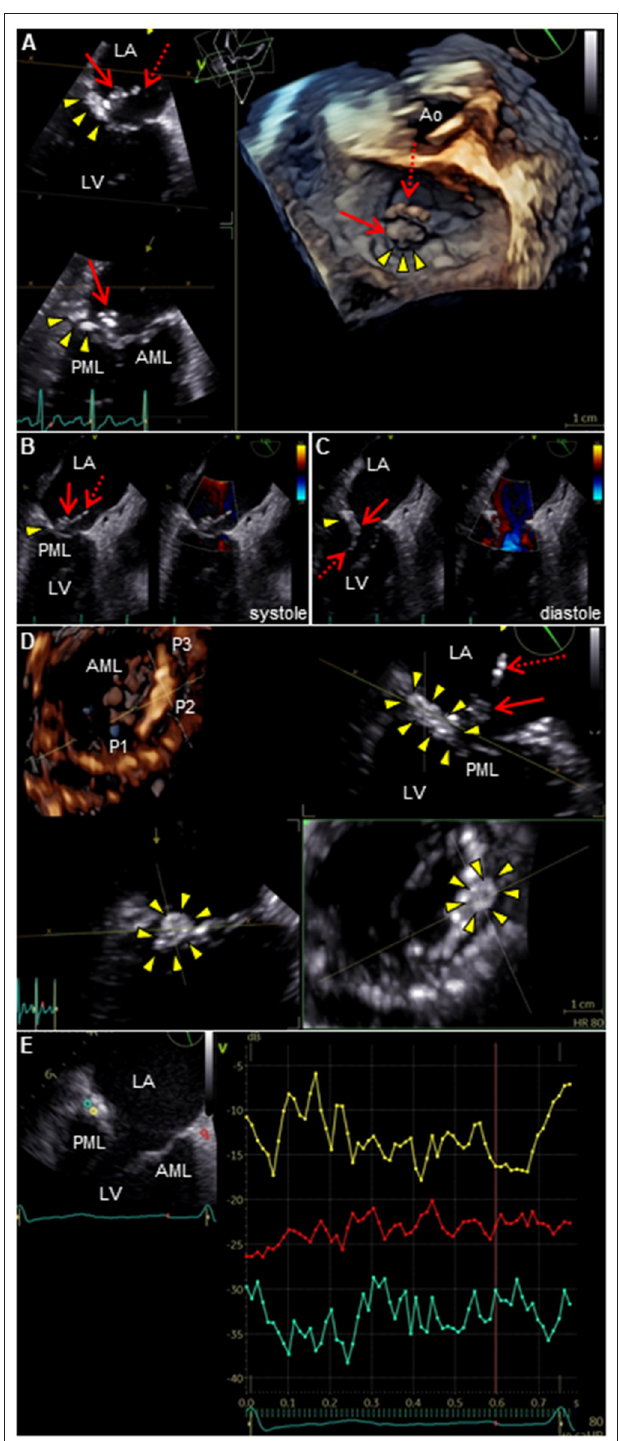
FIGURE 2 | TEE of the mitral valve. (A) 3D TEE or (B,C) 2D color Doppler TEE shows a long mobile mass of vegetations which consist of body part (arrow) and tail part (dotted arrow), containing calcium-dense stippling, attached to the calcified posterior mitral annulus (arrowheads). Note the intact valve leaflets. (D) 4D TEE with Flexi-slice mode demonstrates MAC with a central echolucent area (arrowheads) around the P2 segment of the mitral